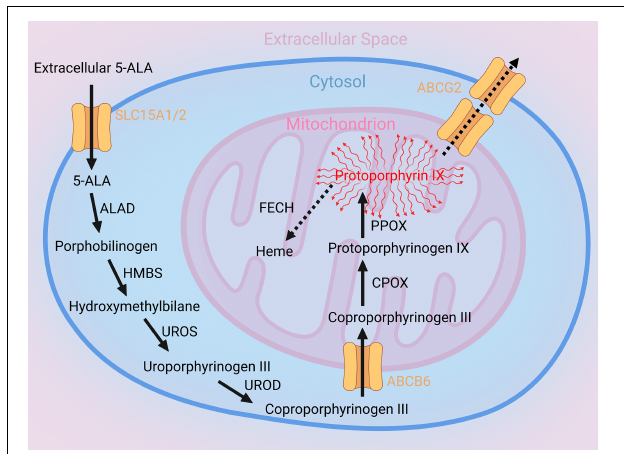
FIGURE 1 | Illustration of the heme biosynthesis pathway catalyzing 5-aminolevulinic acid (5-ALA) to fluorescent Protoporphyrin IX (PpIX). After metabolization of 5-ALA within the intracellular space, the ATP-binding cassette super-family B member 6 (ABCB6), a mitochondrial protein, transports Coproporphyrinogen III from the intracellular space into the mitochondrion. Subsequently, Coproporphyrinogen III is decarboxylated by the Coproporphyrinogen oxidase (CPOX) and generates Protoporphyrinogen IX. In the next step, Protoporphyrinogen oxidase (PPOX) catalyzes Protoporphyrinogen IX to fluorescent PpIX. This fluorescent metabolite is on the one hand transported outside the cell by ATP-binding transporter Cassette Subfamily G member 2 (ABCG2) and on the other hand enzymatically modified to Heme by Ferrochelatase